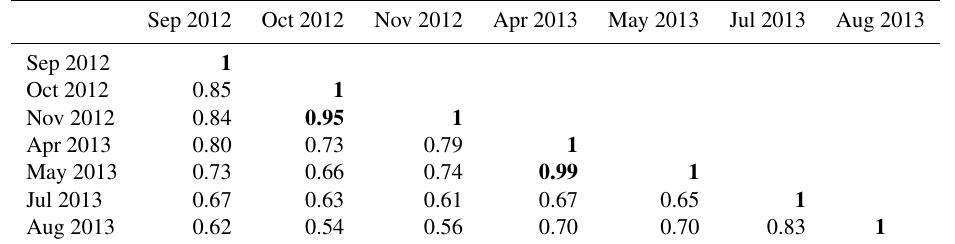
Table 3. Spearman rank correlation coefficients ( r s ) between spatial patterns of soil moisture ( θ d,05 ) in the topsoil. Values of r s ≥ 0.9 are highlighted in